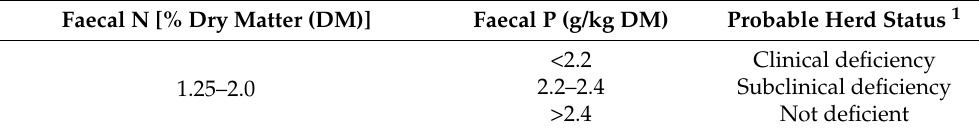
Table 4. Interrelation between faecal N and P values obtained from cattle not supplemented with P and kept in pastures of Urochloa decumbens or U. brizantha , during the middle to the end of the wet